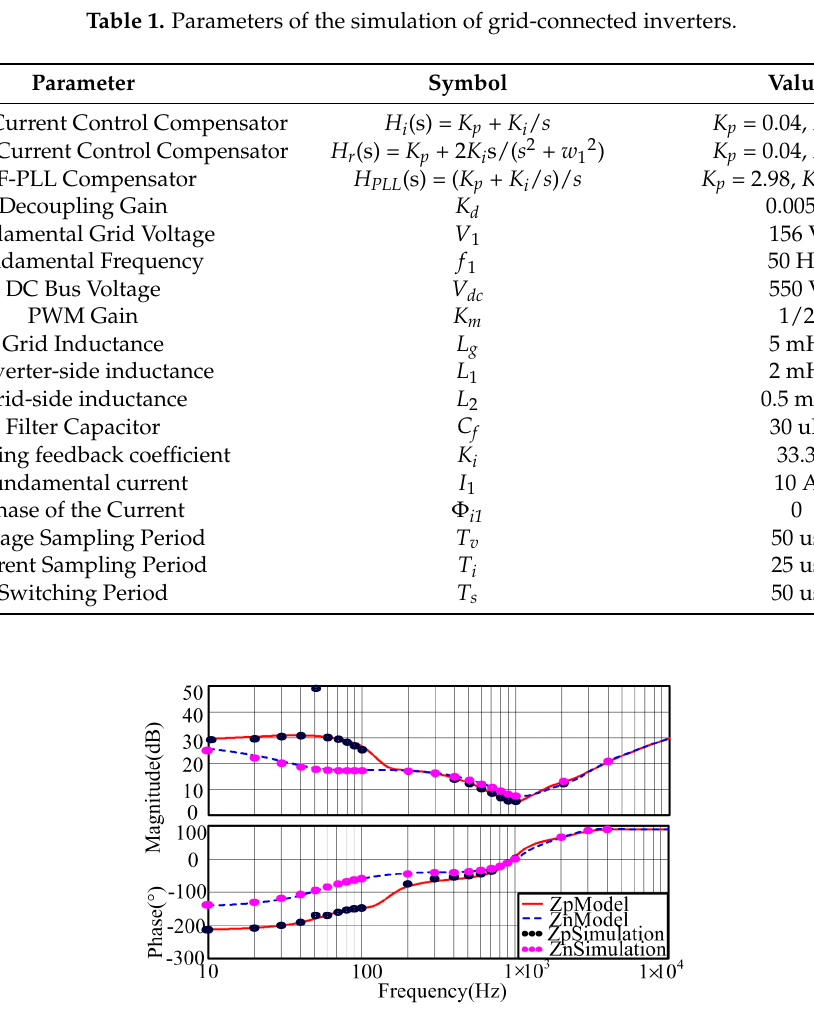
Figure 7. Impedance response with dq -domain GC control.